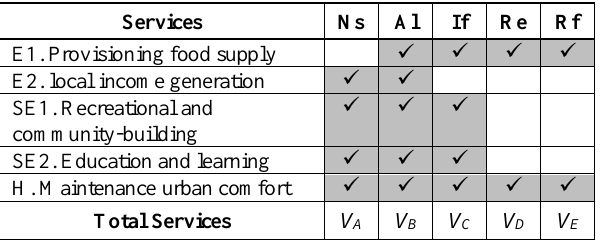
Table 1. Measurement indicators for each urban farming form Figure 3. Identifying and mapping existing urban farming (Ns: Nursery; Al: Allotment; If: Institutional; Re: Residential; and Rf: Rooftop farming)